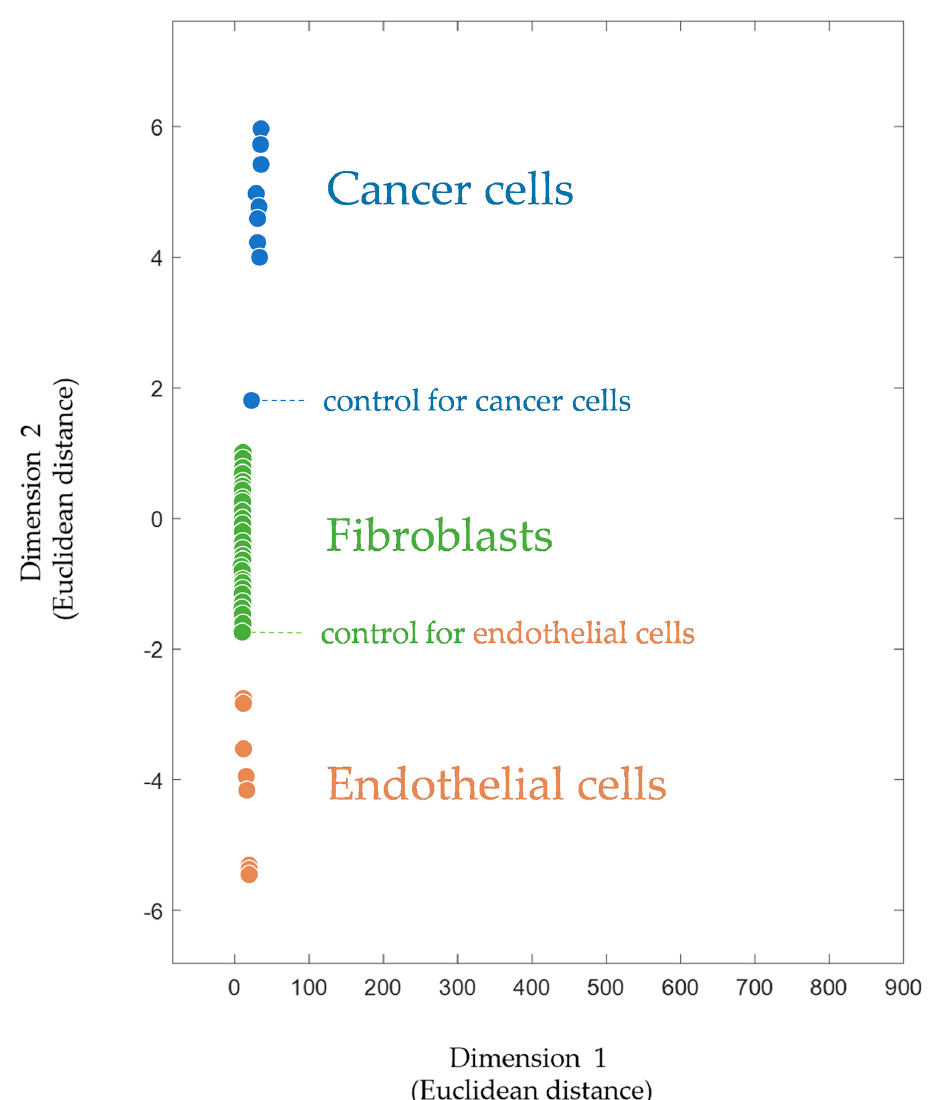
Figure 3. Multidimensionally scaled cell proteomic footprints of various cell types. Footprints of endothelial cells ( ● ) are taken from [31] and correspond to primary cultures of human microvascular endothelial cells (HMECs) with native and tumor-induced phenotypes and from different donors. Footprints of fibroblasts ( ● ) are taken from [46] and correspond to primary cultures of human fibro- blasts with different origins. Footprints of cancer cells ( ● ) are taken from [80] and correspond to different cancer cell lines, both untreated and drug-treated. The footprints for this plot as well as the script (for Matlab software, MathWorks, Natick, MA, USA) for their processing are provided in the Supplementary Materials.